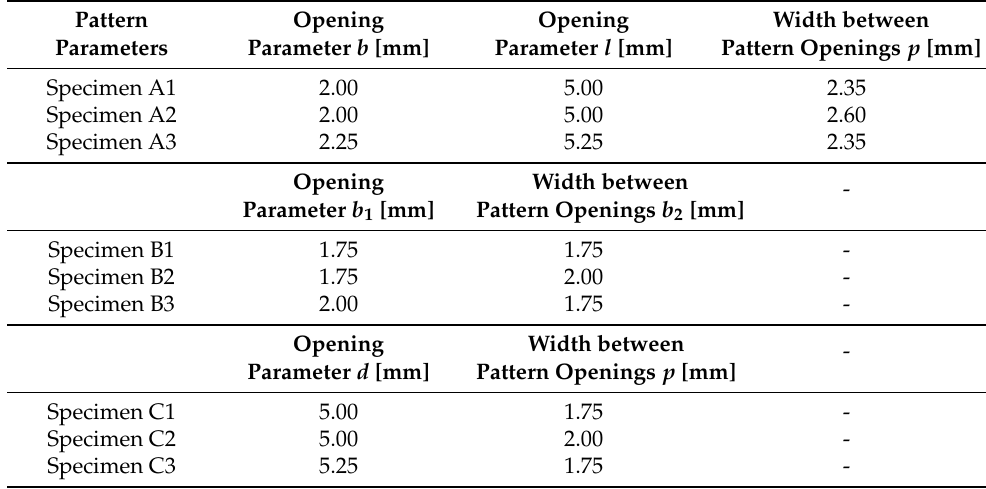
Figure 7. The relationship between the applied force F and measured plunger displacement u . Table 4. Used specimen pattern